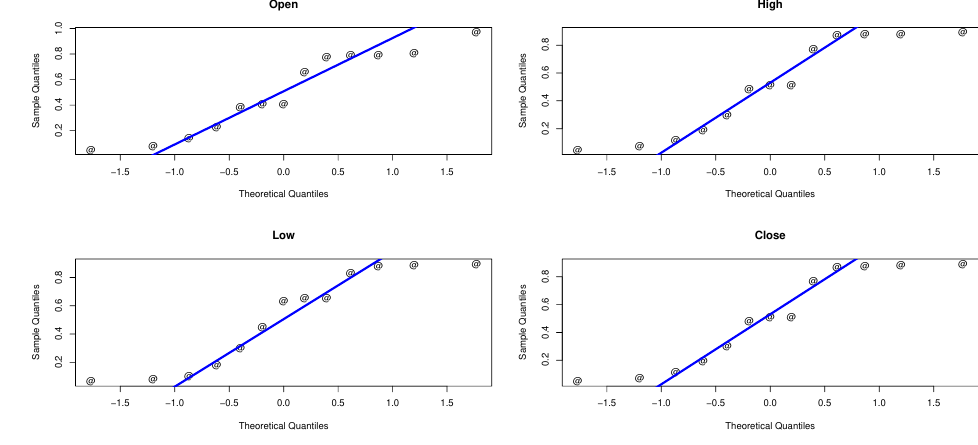
Figure 8. The Q-Q normality plot of the E-WD. The goodness-of-fit results of the E-WD model are compared with some other models, including the Mudholkar exponintiated Weibull distribution [27] (MEWD), the generalized Weibull Modified Weibull distribution (GWMWD), the generalized Weibull-Rayleigh